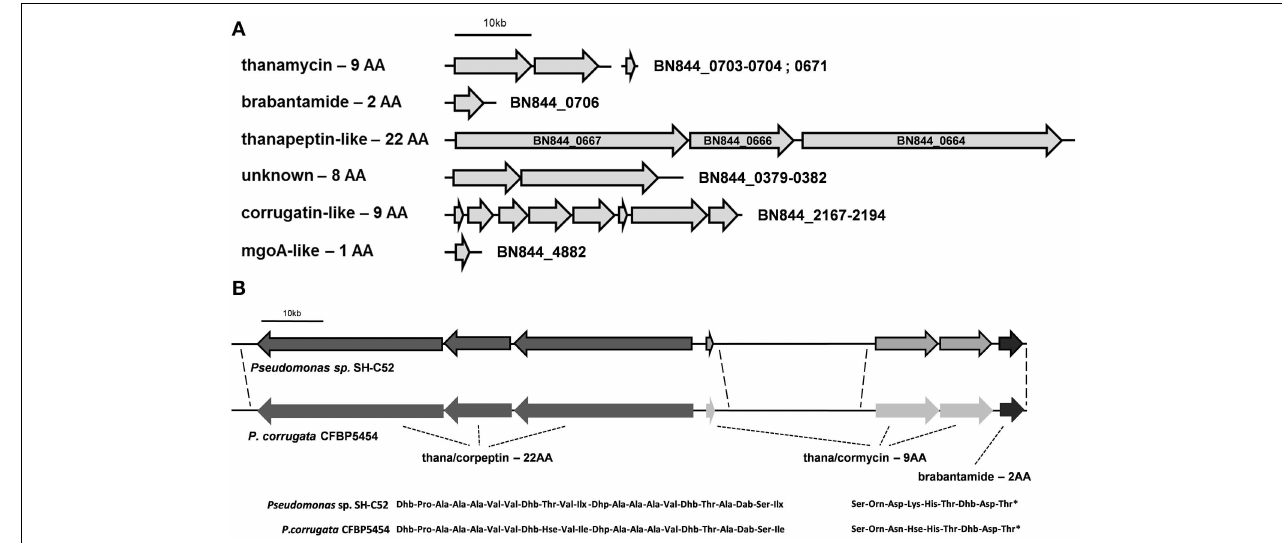
FIGURE 2 | Non-ribosomal peptide synthetase gene clusters present in the genome of Pseudomonas sp. SH-C52. (A) The six NRPS gene clusters predicted in the genome of SH-C52. (B) A comparison of the SH-C52 thanamycin-thanapeptin-brabantamide cluster with the putative equivalent cluster of P. corrugata CFBP5454. Thana/corpeptin related NRPS genes are in dark gray, thana/cormycin NRPS genes are in light gray, and brabantamide genes are in near black. The P. corrugata genes are not bordered, as the genome